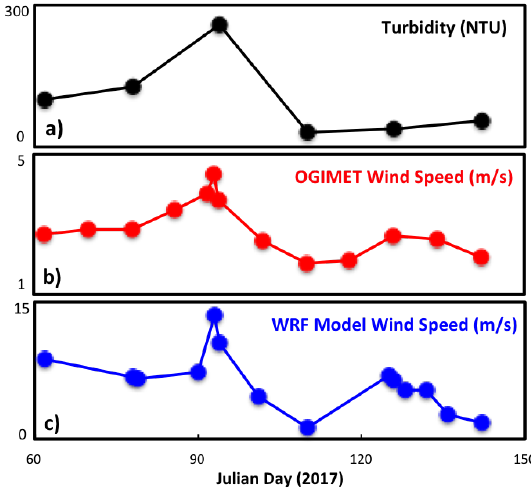
Figure 7. Temporal variability of turbidity and wind speed in Laguna de Bay. Wind data were acquired from NOAH-WISE Weather Research Forecast (WRF) Model and OGIMET synoptic stations. Note that the wind data from four synoptic stations that surround Laguna de Bay (Tayabas, Tanay, Ambulong and NAIA) were averaged, whereas, the data shown from NOAH-WISE corresponds to the modeled wind at the central